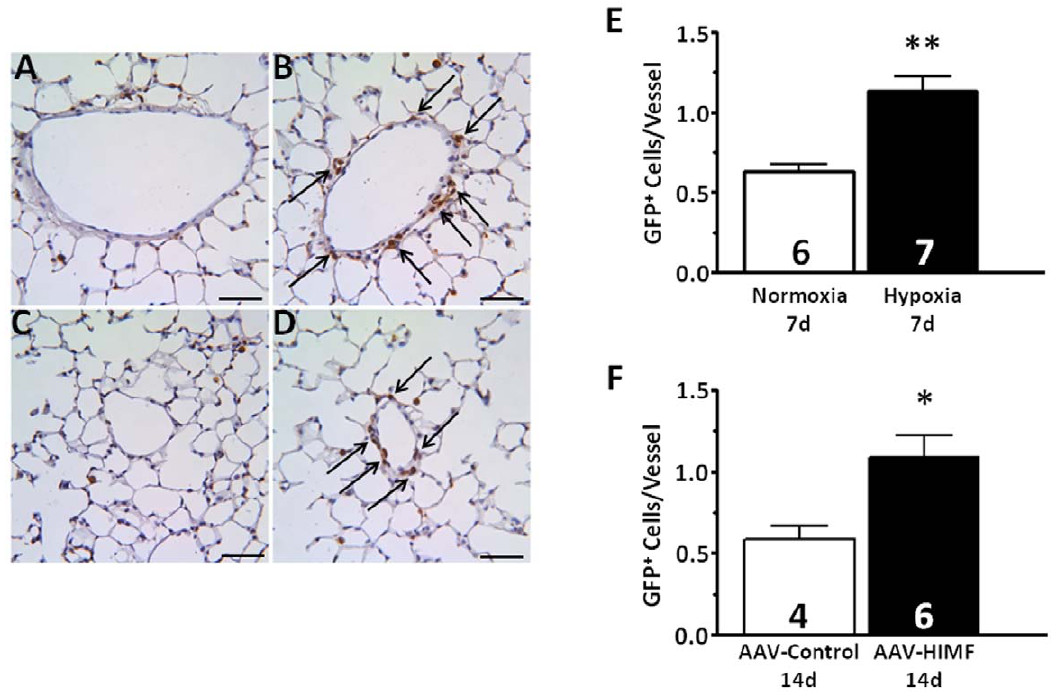
Figure 2. Chronic hypoxia and pulmonary HIMF gene transfer increase the number of BMD cells associated with the pulmonary vasculature. A–D: Paraffin-embedded lung sections from mice exposed to normoxia (7d, 20.8% O 2 ) (A), hypoxia (7d, 10.0% O 2 ) (B), AAV-null (14d, 2.5 6 10 10 VP) (C), or AAV-HIMF (14d, 2.5 6 10 10 VP) (D) were probed with polyclonal antibodies raised against GFP. Arrows indicate GFP + cells within the vasculature. Scale bar: 50 m m. E, F: Quantification of GFP + cells within the pulmonary vasculature. GFP + cells within the pulmonary vasculature are shown as mean 6 SEM of GFP + cells/vessel. * P , 0.05, ** P , 0.01 vs. control.